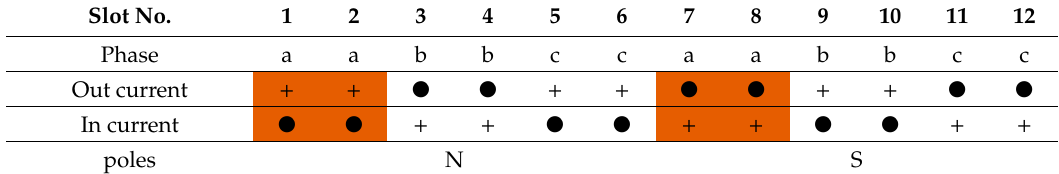
Table 3. 12 slot winding currents for traditional toroidal winding solid rotor induction